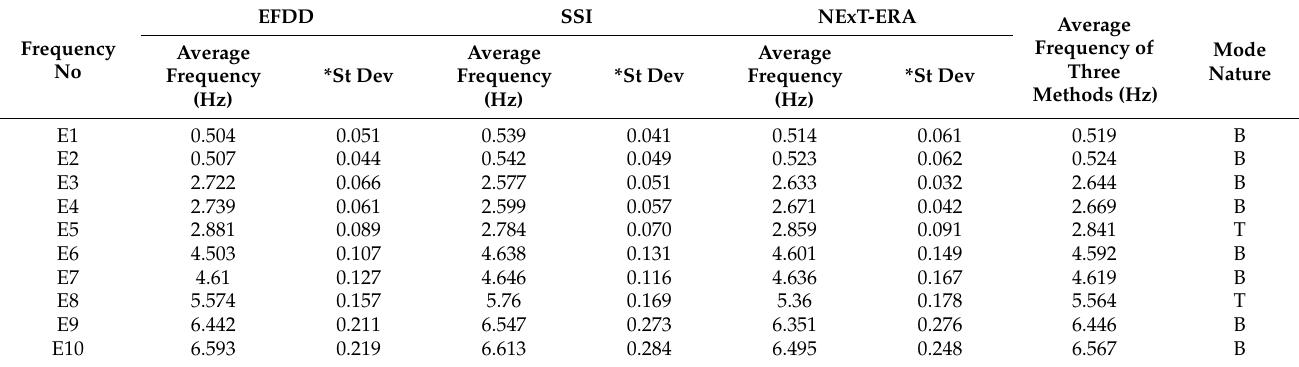
Table 1. First ten average identified frequencies from the three identification methods.